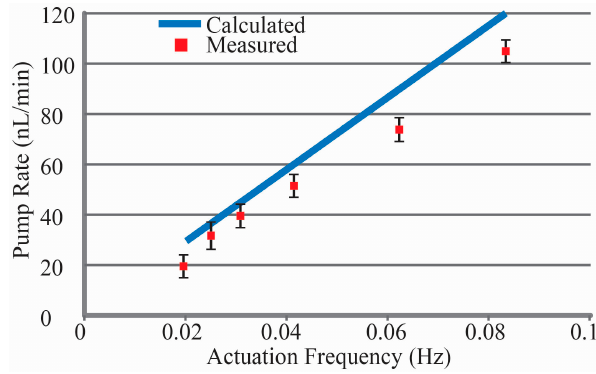
Figure 9. Pump rate vs. actuation frequency for the micropump compared to theoretical rates based upon chamber volume design ( n = 3). Lower flow rates are possible with duty cycle control, while higher rates can be achieved with larger chambers and scaling of the Ga.